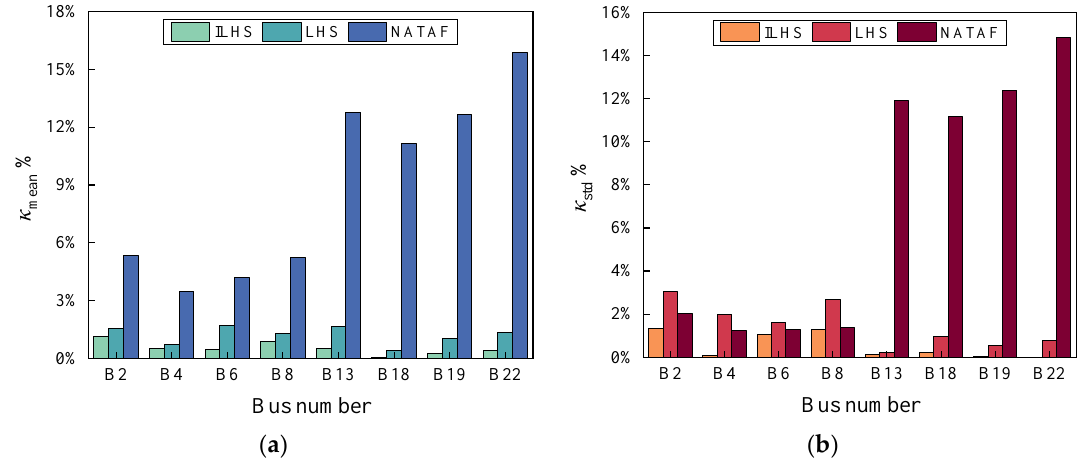
Figure 8. Comparison of ( a ) the mean error and ( b ) the standard deviation error of the AC bus voltage phase angles.